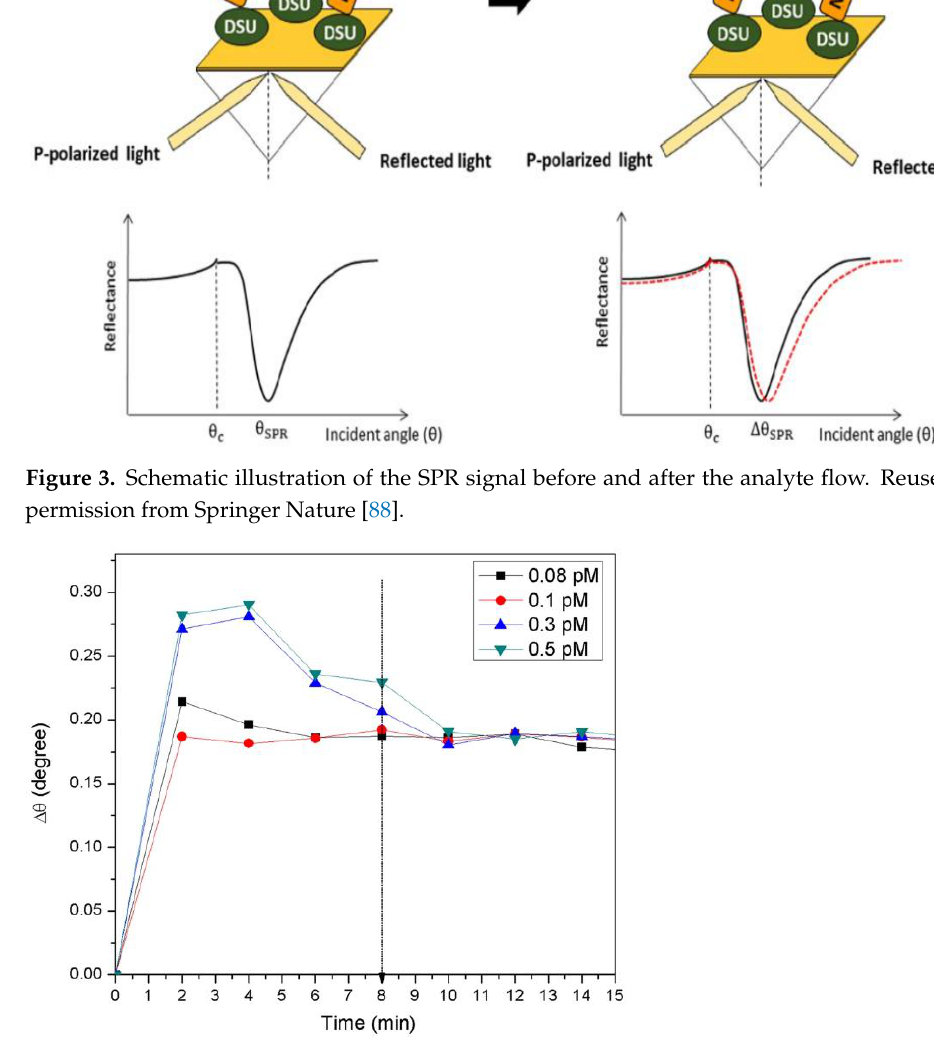
Figure 5. Experimental SPR curves when Au/DSU/NH 2 rGO-PAMAM/IgM sensor film was exposed to 0.08 – 0.5 pM of DENV-2 E-proteins. Reused with permission from Springer Nature [88]. The results revealed that because of different spin speeds and incubation times, the varying sensor layer and concentration yielded more interaction between the sensing layer and the analyte. The sensor exhibited good linearity (R 2 = 0.92), and DENV-2 E-pro- teins of concentration as low as 0.08 pM were detected in 8 min [88]. The rGO is advantageous over the GO as it possesses a longer storage duration with- out clustering, and is stable in organic solvents. A combination of polyadinoamine (PA- MAM) dendrimer with rGO paves the way to improve the detection ’ s sensitivity. PA- MAM dendrimers possess multiple benefits in applications related to sensing due to their enhanced binding site on the dendrimer and capability for the transportation of bioactive agents [90], which led to an increase in the number of active sites for binding DENV E- proteins. The thin film-integrated SPR sensor could be developed as a point-of-care device in the future [88].